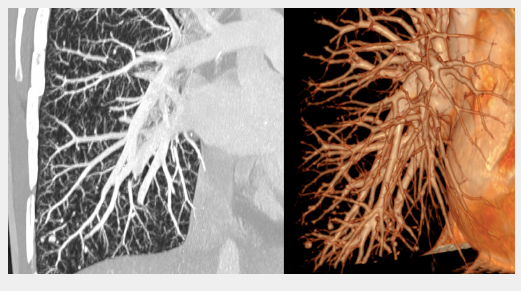
Maximun intensity imaging and 3D reconstructions of pulmonary computed tomography angiography showing numerous pulmonary